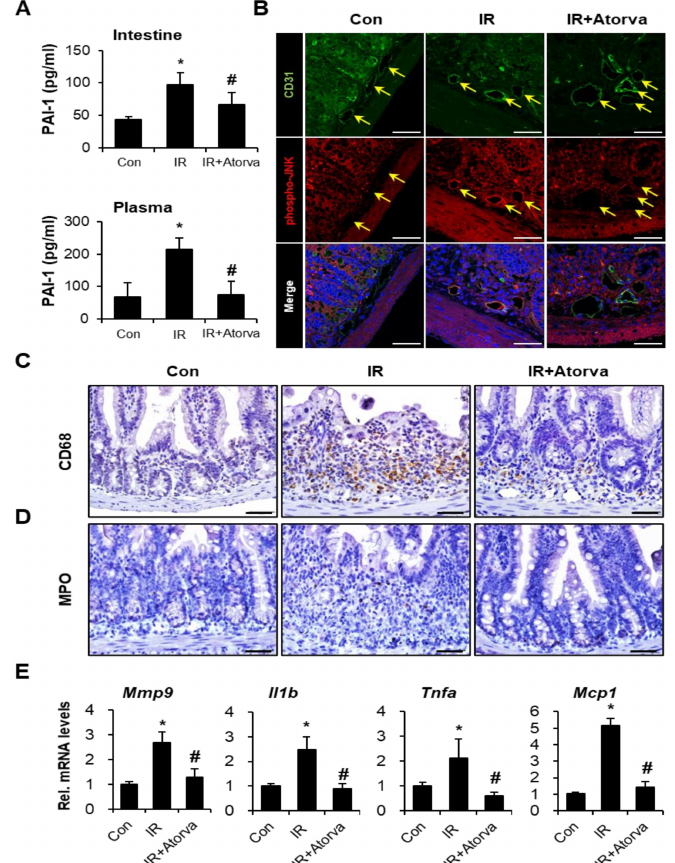
Figure 6. Atorvastatin mitigates the radiation-induced inflammatory response in vivo by inhibiting PAI-1 expression. ( A ) Small intestine and plasma PAI-1 levels in control (Con), irradiated (IR), and atorvastatin (Atorva)-treated IR (IR + Atorva) mice. Immunohistochemistry of ( B ) CD31 (an endothelial cell marker; Green) and phospho-JNK (Red), ( C ) CD68, a monocyte maker, and ( D ) myeloperoxidase (MPO), a neutrophil marker, in intestinal tissue. The yellow arrows indicate CD31-positive endothelial cells. ( E ) mRNA levels of (pro)-inflammatory cytokines Mmp9, Il1b, Tnfa, and Mcp1 in the intestinal tissue of Con, IR, and IR + Atorva groups. Data are presented as the mean ± standard deviation of the mean; n = 5 mice per group. * p < 0.05 compared to the Con group; # p < 0.05 compared to the IR group. Scale bars represent 50 µ